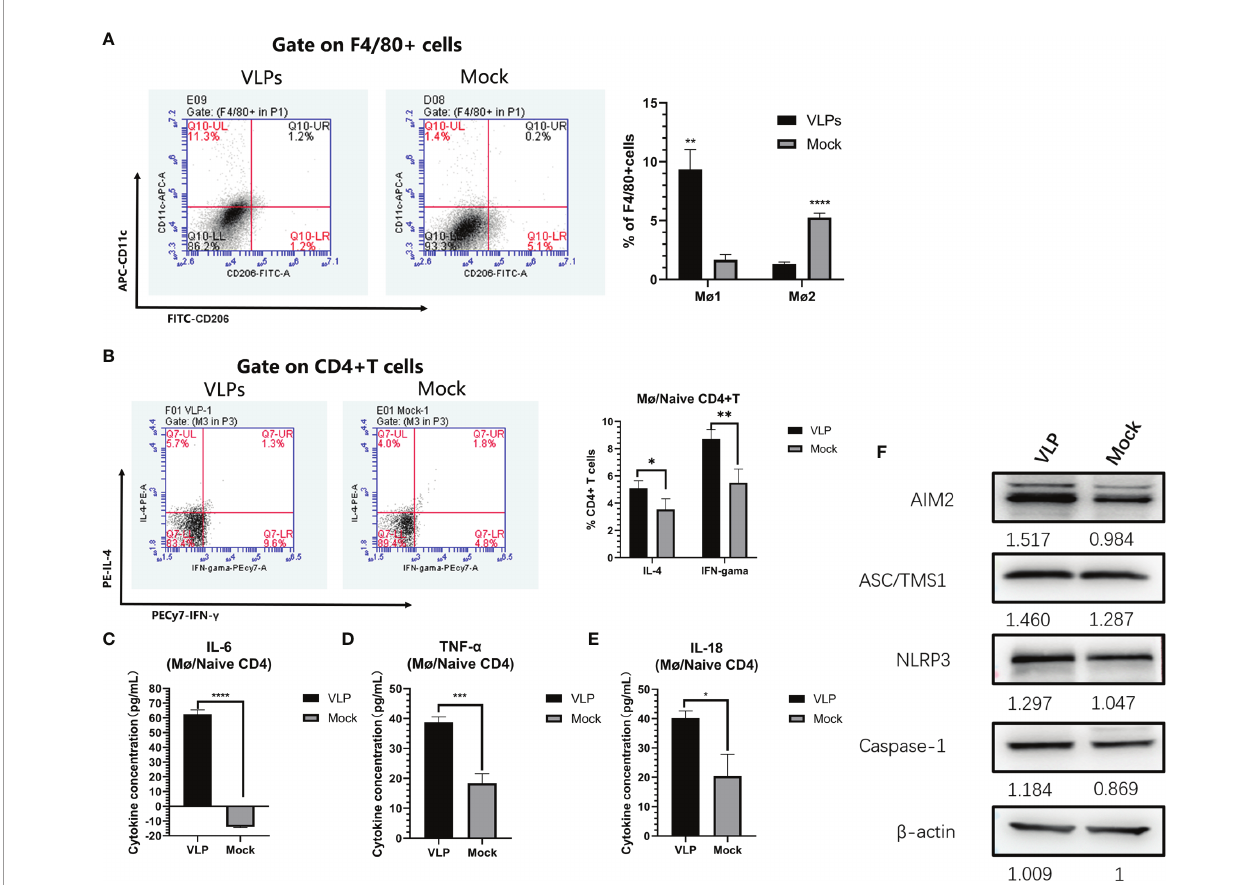
FIGURE 6 | In vitro analysis of antigen presentation in macrophages. Macrophages and naïve CD4+T were mixed and incubated at a ratio of 1:5 for 3 hours, before treatment with PBS (Mock) or VLPs (10 m g) for 48 h, respectively. Thereafter, fl ow cytometry was used to compare macrophage polarization (A) and the cellular expression of IL-4 and IFN- g in CD4+ T cells (B) . In parallel, culture supernatants were harvested to measure the secreted levels of IL-6 (C) , TNF- a (D) and IL-18 (E) . The co-cultured cells were harvested and key proteins in the NLRP3 in fl ammation pathway measured by Western blotting (F) . All experiments were performed independently at least thrice and results were presented as means ± standard deviation. Signi fi cance levels were de fi ned as *p < 0.05, **p < 0.01, ***p < 0.001 and ****p <